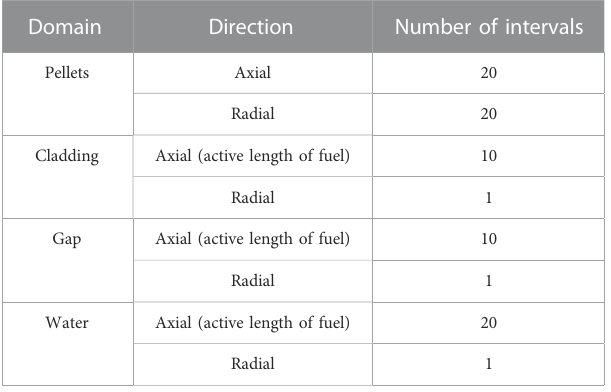
TABLE 4 Fuel rod lattice mesh parameters used by